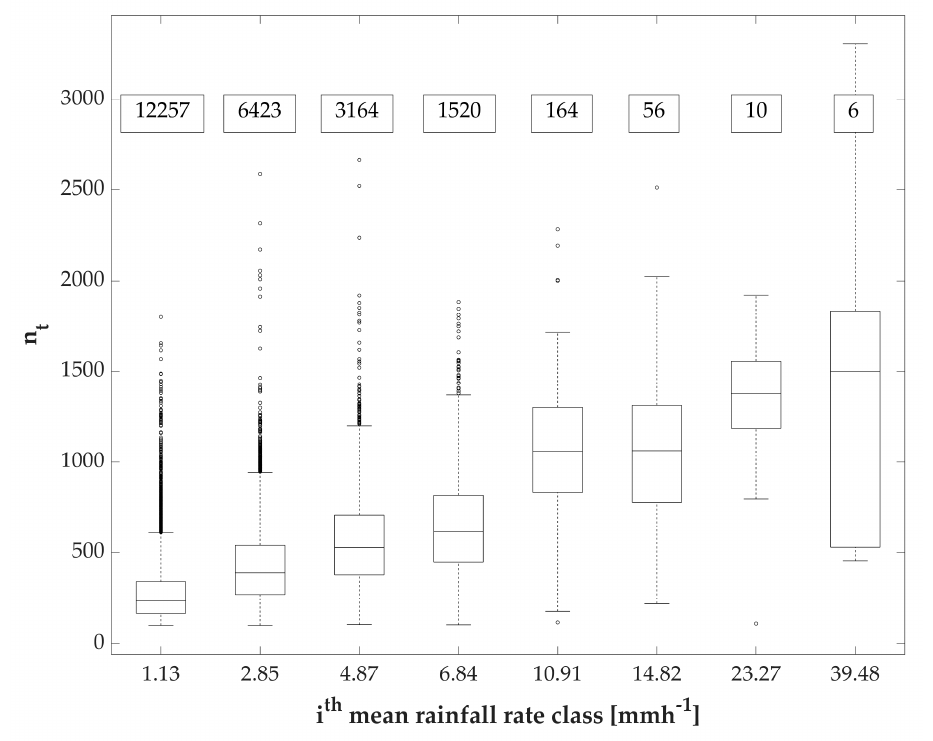
Figure 9. Number of total drops falling per each 1 min drop spectrum vs. average intensity class. In correspondence with each rainfall rate class, at the top of the panel inside the boxes, the number of 1 min drop spectra is reported.